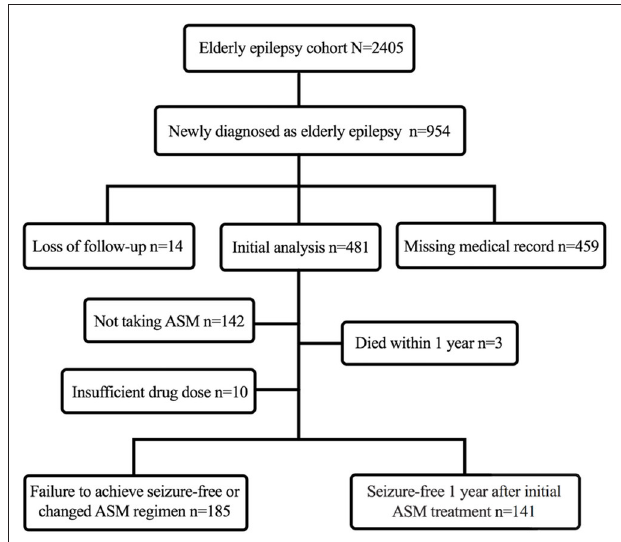
FIGURE 1 | Flowchart of constructing a cohort of new-onset epilepsy in the